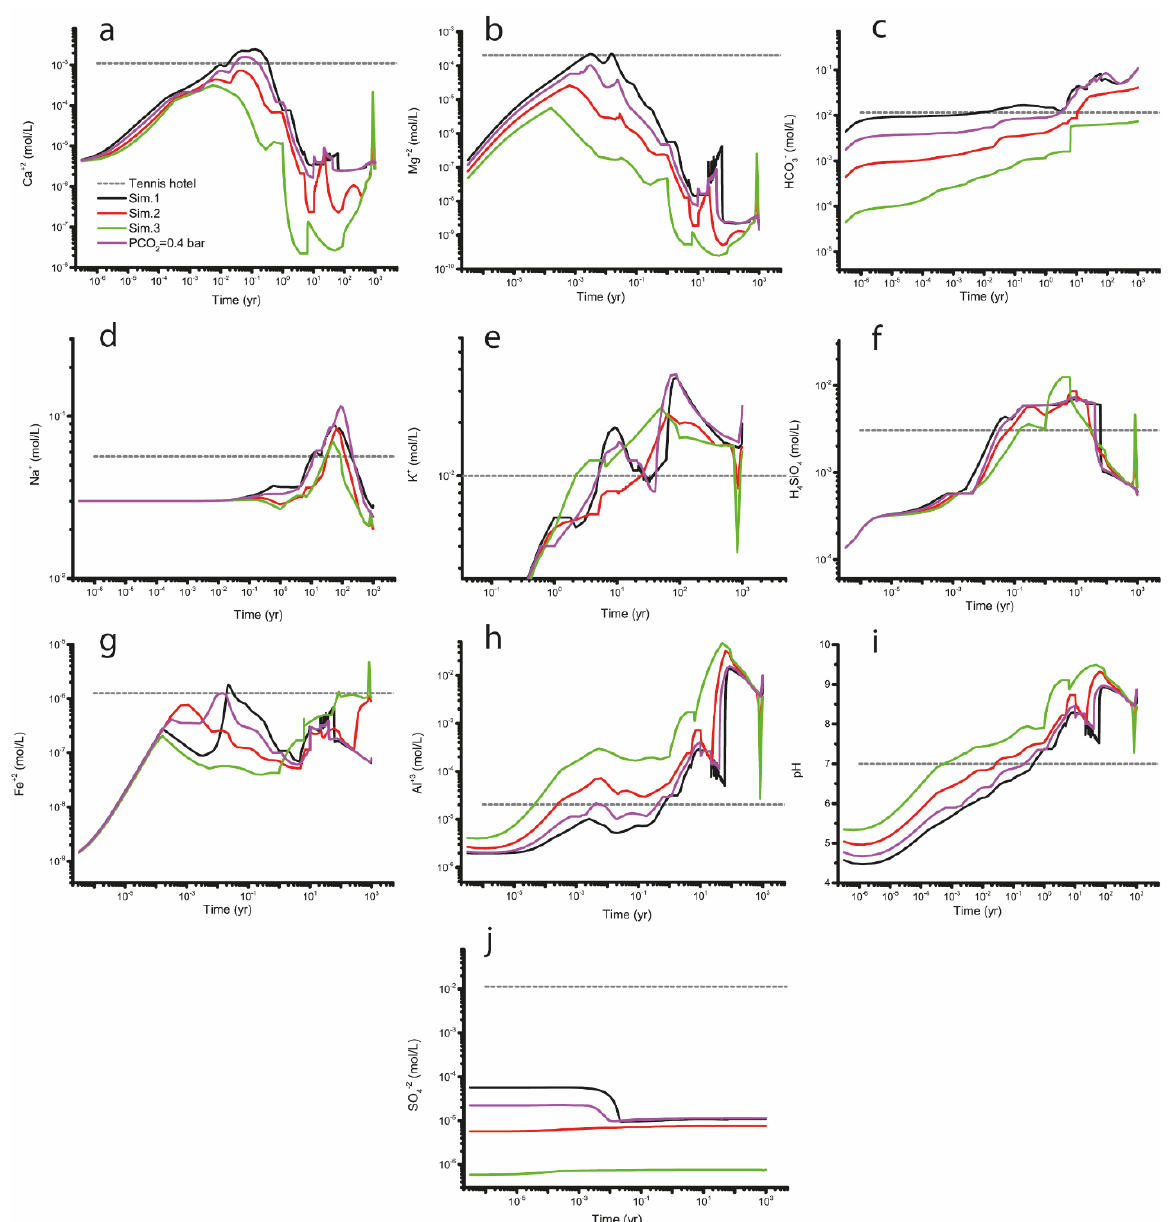
Figure 10. Simulations 1, 3 and PCO 2 = 0.4 bar: an aqueous species evolution over time at 165 °C, PCO 2 = 1.2 bar (black lines), PCO 2 = 0.12 bar (red lines), PCO 2 = 0.012 bar (green lines) and PCO 2 = 0.4 bar (purple lines). Simulation results were compared to the geochemical analysis of the Tennis hotel (gray dash lines; Table 3). ( a ) Ca +2 ; ( b ) Mg +2 ; ( c ) HCO 3- ; ( d ) Na + ; ( e ) K + ; ( f ) H 4 SiO 4 ; ( g ) Fe +2 ; ( h ) Al +3 ; ( i ) pH and ( j ) SO 4 −2 . The initial water composition of simulations was set as a NaCl (0.033 M) equivalent water, with neutral pH and initial concentrations of 1 × 10 − 9 mol/L for all the other ions and neutral species.